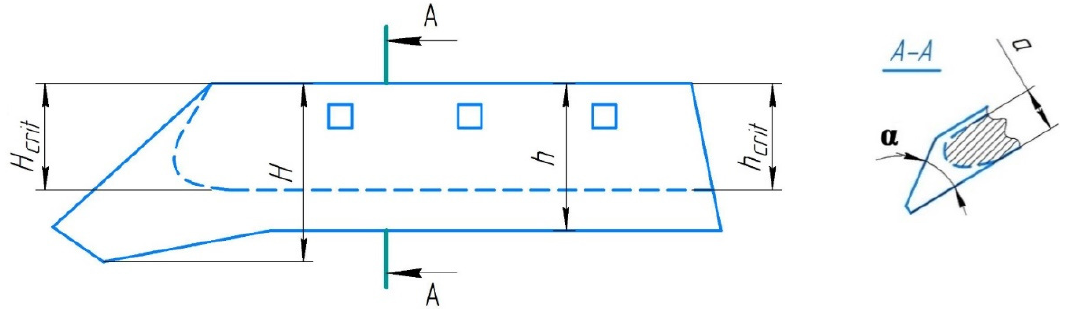
Figure 1. The rejecting parameters of the ploughshare.